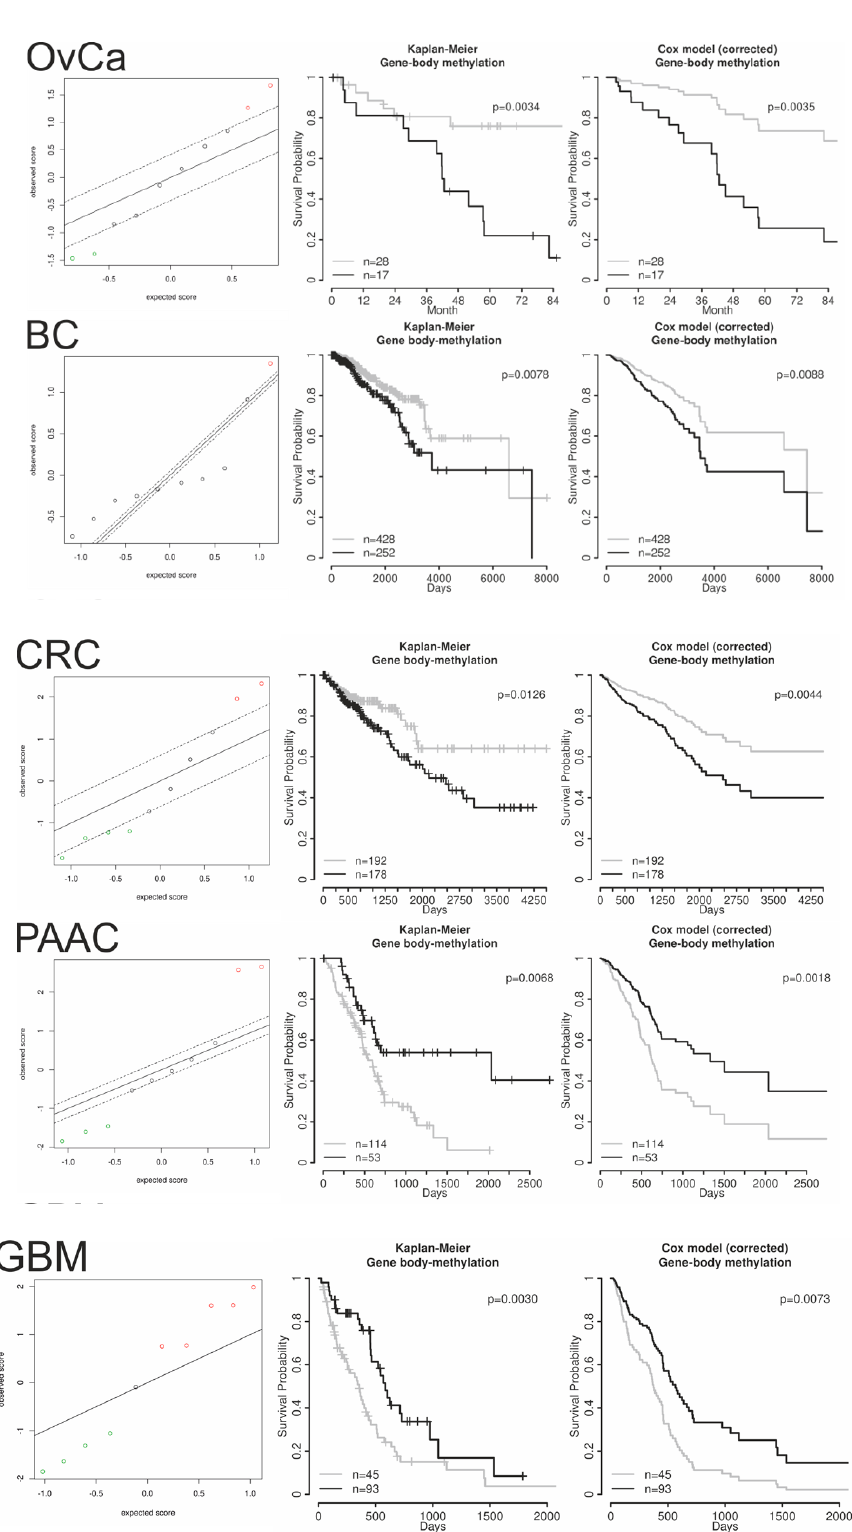
Figure 2. Significance Analysis of Microarray (SAM) plots of Cox regressions (X-axis, expected score; Y-axis, observed score; dashed line, threshold cutoff at 5% false discovery rate, FDR; red dots, associated with unfavorable overall survival (OS); green dots, associated with favorable OS), Kaplan–Meier estimates of the optimally dichotomized MDF / MUMF, and survival curves of the corrected Cox regression models (details are given in Table 1). (No censored patients are indicated for the latter plots, as these are survival estimates from multiple Cox regression models).